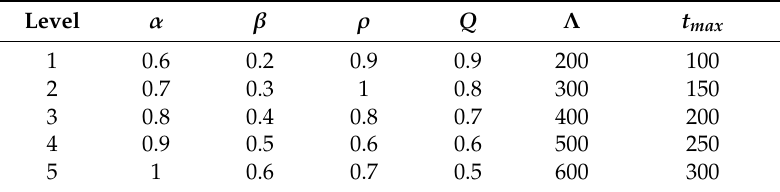
Table A3. ACO algorithm parameters level.